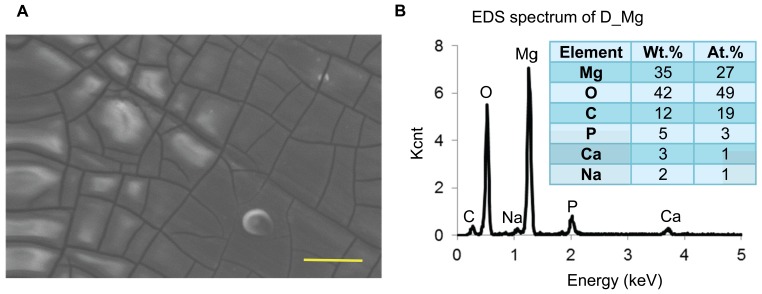
Surface morphology and composition of D-Mg.(A) SEM image and (B) EDS analysis of the D-Mg sample, showing the presence of a degradation layer on the surface. Accelerating voltage: 15 kV. Original Magnification: 2000x. Scale bar = 20 µm.